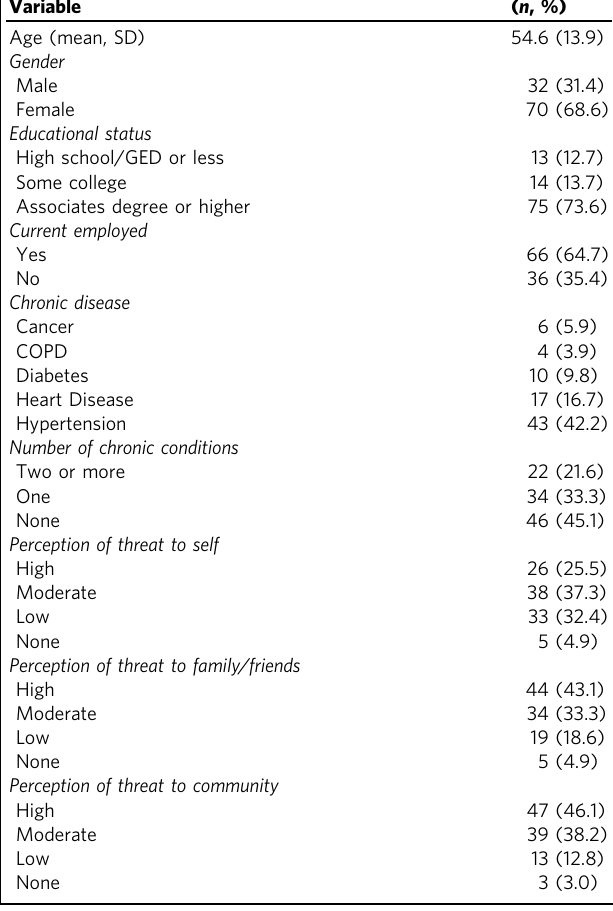
Table 1 Descriptive characteristics of the sample ( N = 102).